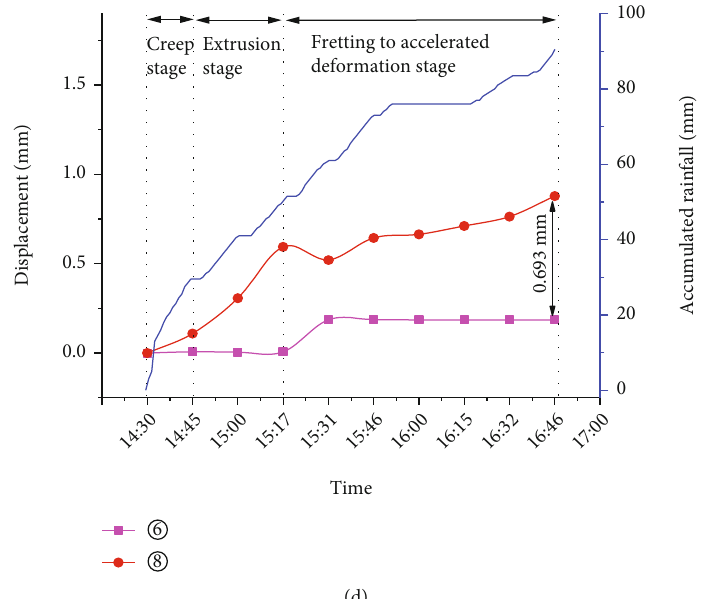
Figure 9: Deformation displacement curve (a). Layout of measuring points (b). The deformation displacement curve of setting the prestressed grouting steel anchor tube side (c). Comparison of deformation displacement curves of the fi ve-level slope (d). Comparison of deformation displacement curves of the four-level